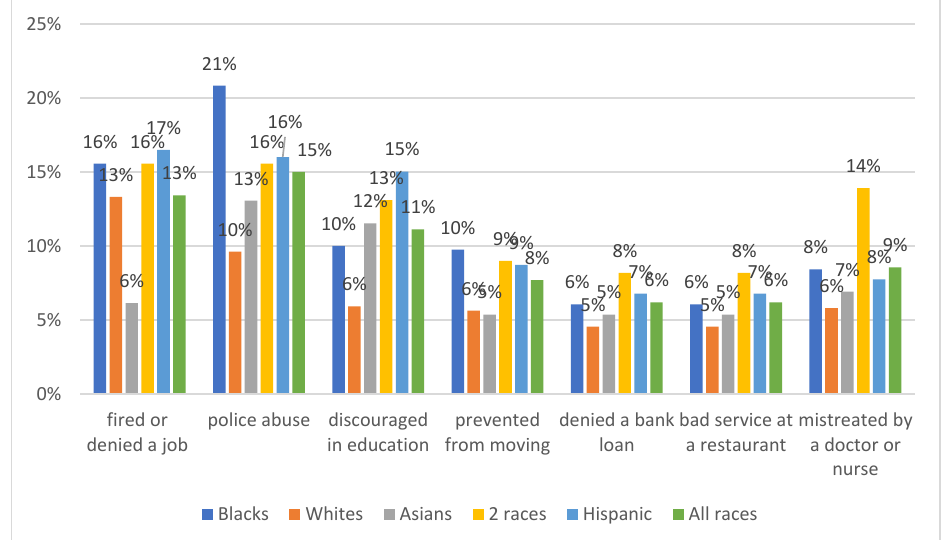
Figure 1. Experience of racial discrimination.